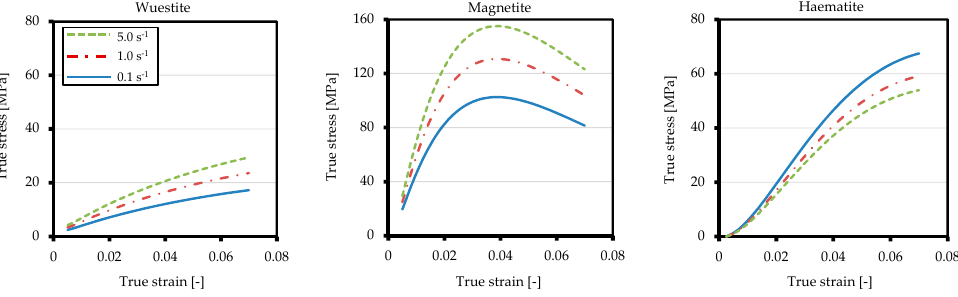
Figure 6. Exemplary calculated flow curves for wuestite, magnetite, and haematite at a temperature of 1000 °C.